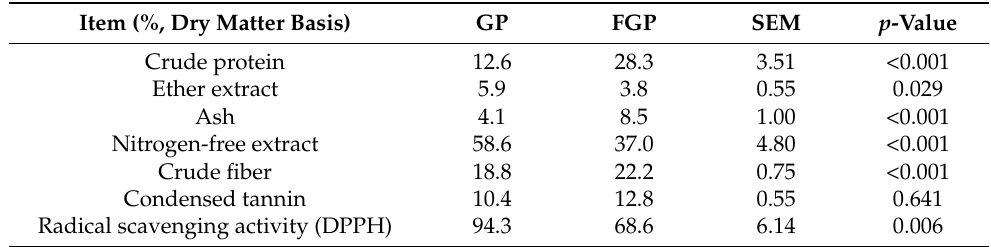
Table 2. Effect of solid-state fermentation on the nutritional composition and radical scavenging activity of grape pomace 1 .